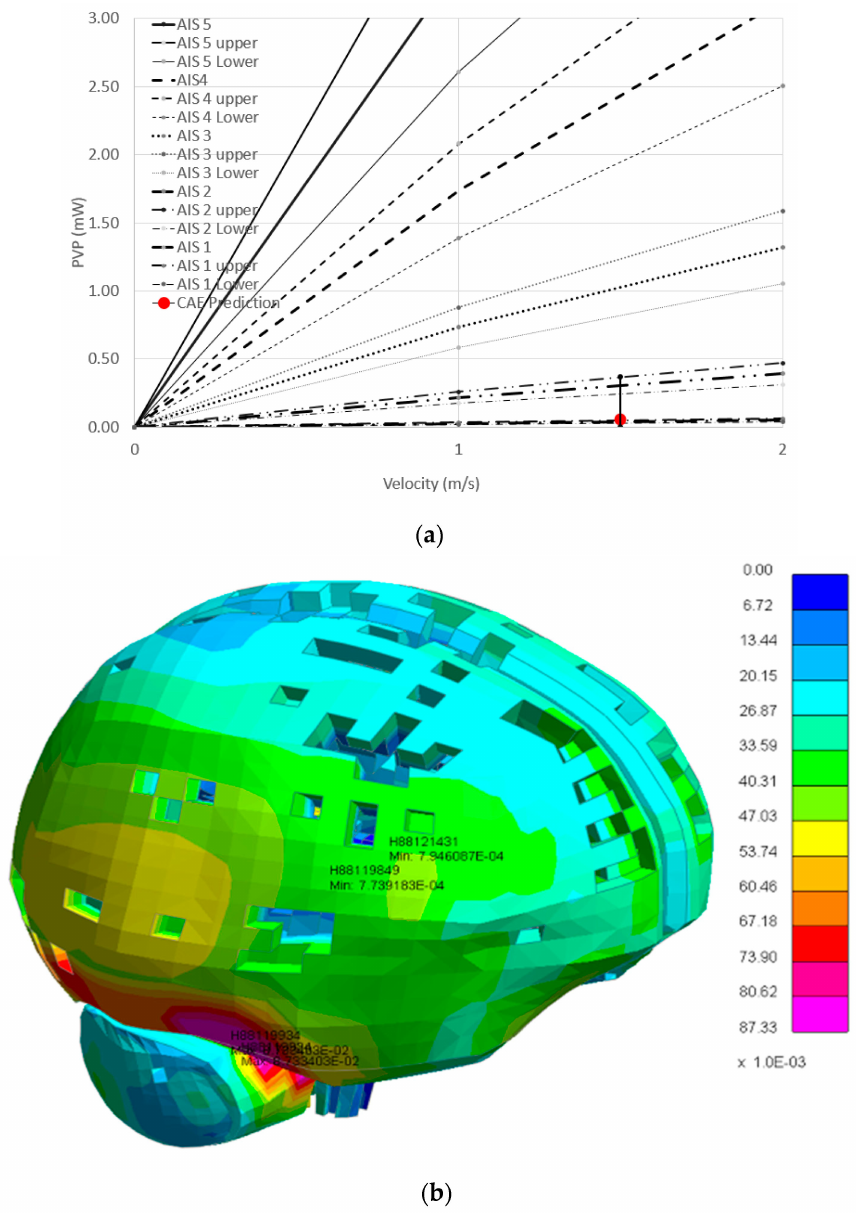
Figure 12. Parietal Grey Matter—OTM Model. ( a ) Parietal grey matter trauma prediction, ( b ) Maximum Principal strain (grey